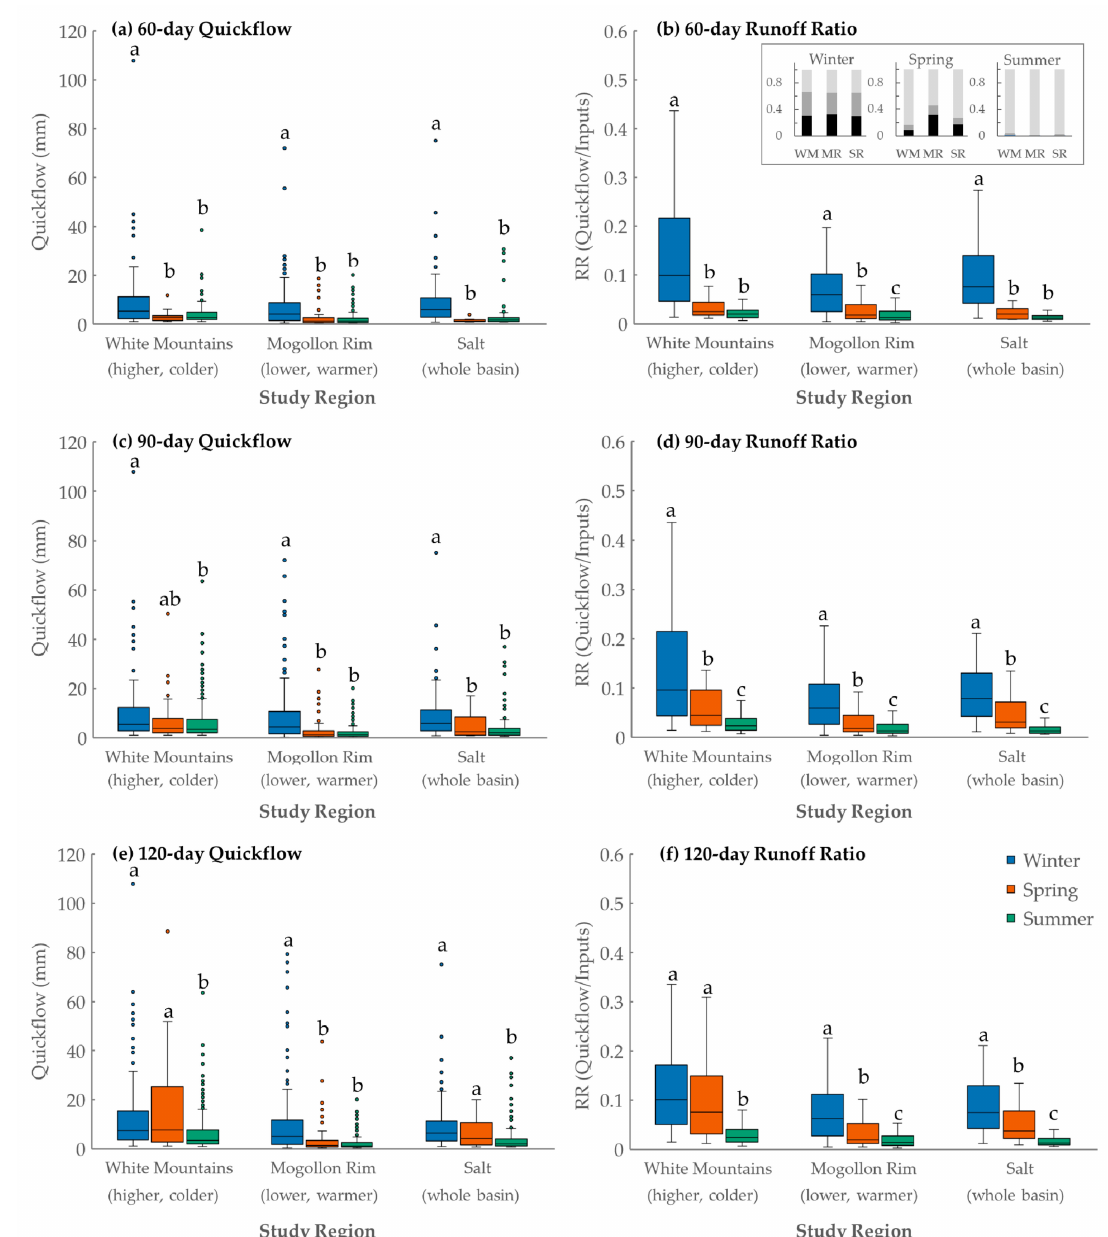
Figure 8. Comparison of quickflow response intervals (QRIs) grouped by season and regions from 1968–2011 for 60-day ( a , b ), 90-day ( c , d ), and 120-day intervals ( e , f ). Left panels show area-normalized quickflow magnitudes (mm); right panels show runoff ratios (Quickflow/hydrological-inputs). Boxes show interquartile range, horizontal line is median, whiskers are 10 to 90 percentiles, dots are outliers (RR outliers not shown). a, b, c letters above individual bars indicate significant differences at p < 0.05 using the Mann-Whitney U-test. Inset panel in ( b ) shows percent hydrological inputs (black for snowmelt, grey for rain-on-snow, light grey for rainfall) in White Mountains (WM), Mogollon Rim (MR), and Salt River (SR) regions for 60-day QRIs in winter, spring, and